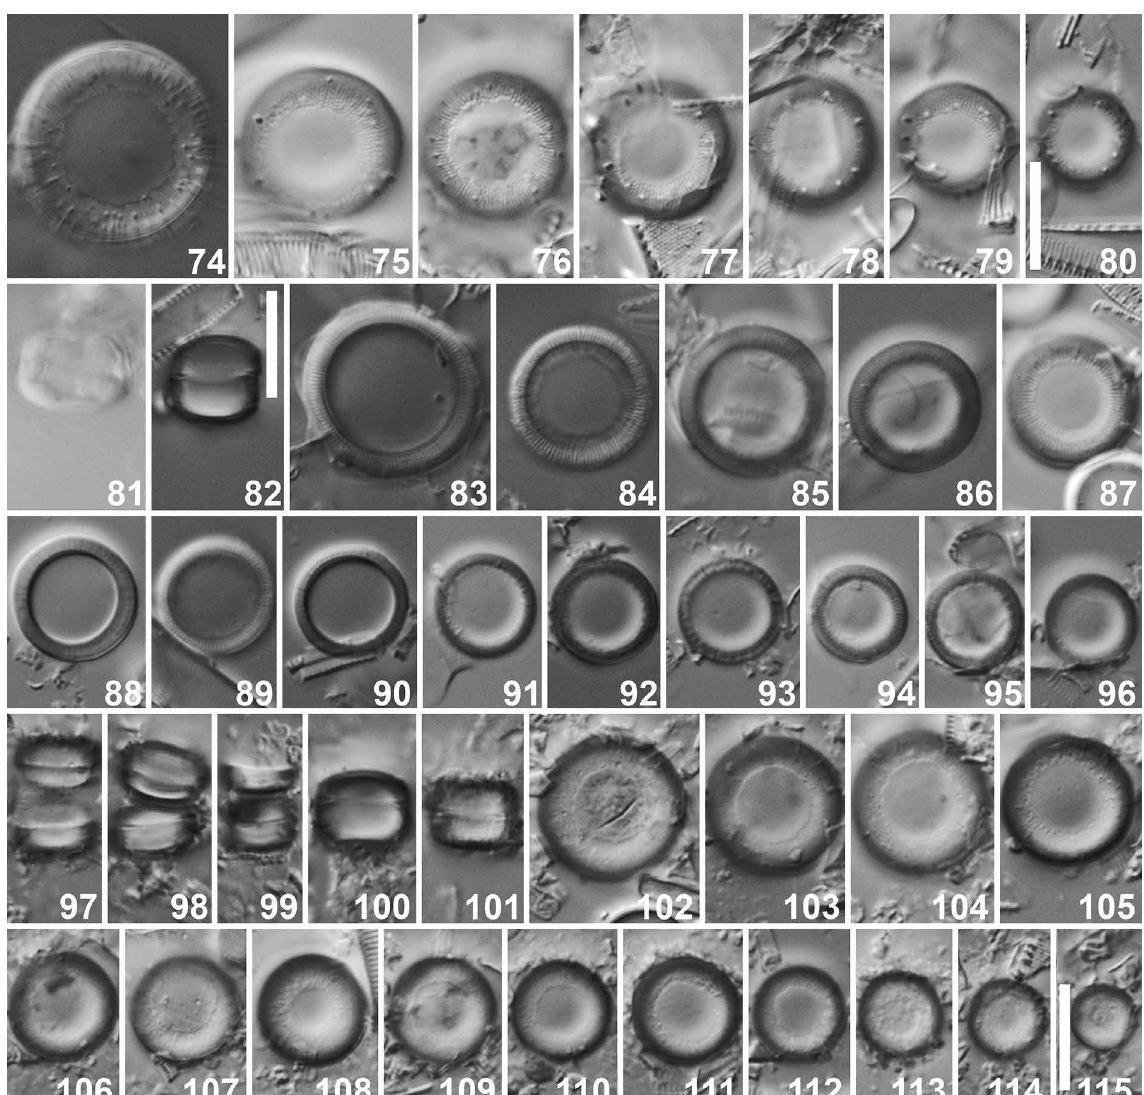
Figs 74–115. Three new Arcanodiscus species from Campbell Island. 74–80 . Arcanodiscus crawfordianus Goeyers & Van de Vijver sp. nov. LM. Campbell Island holotype population, sample BAS303 (BR-4579). Several valves in valve face view showing clearly the large central area, the irregularly scattered spines and the marginal striae. 81–96 . Arcanodiscus indistinctus Goeyers & Van de Vijver sp. nov. LM. Campbell Island holotype population, sample BAS303 (BR-4580). 81 . Frustule in girdle view showing the discoid chloroplasts. 82 . Frustule in girdle view. 83–96 . Several valves in valve face view. Note the thick mantle in some of the valves and the large central area. 97–115 . Arcanodiscus saundersianus Goeyers & Van de Vijver sp. nov. LM. Campbell Island holotype population, sample BAS272 (BR-4581). 97–101 . Several frustules in girdle view, often connected to each other. 102–115 . Several valves in valve face view. Note the thick mantle in some of the valves and the relatively small central area. The marginal striae are hardly visible in LM. Scale bars = 10